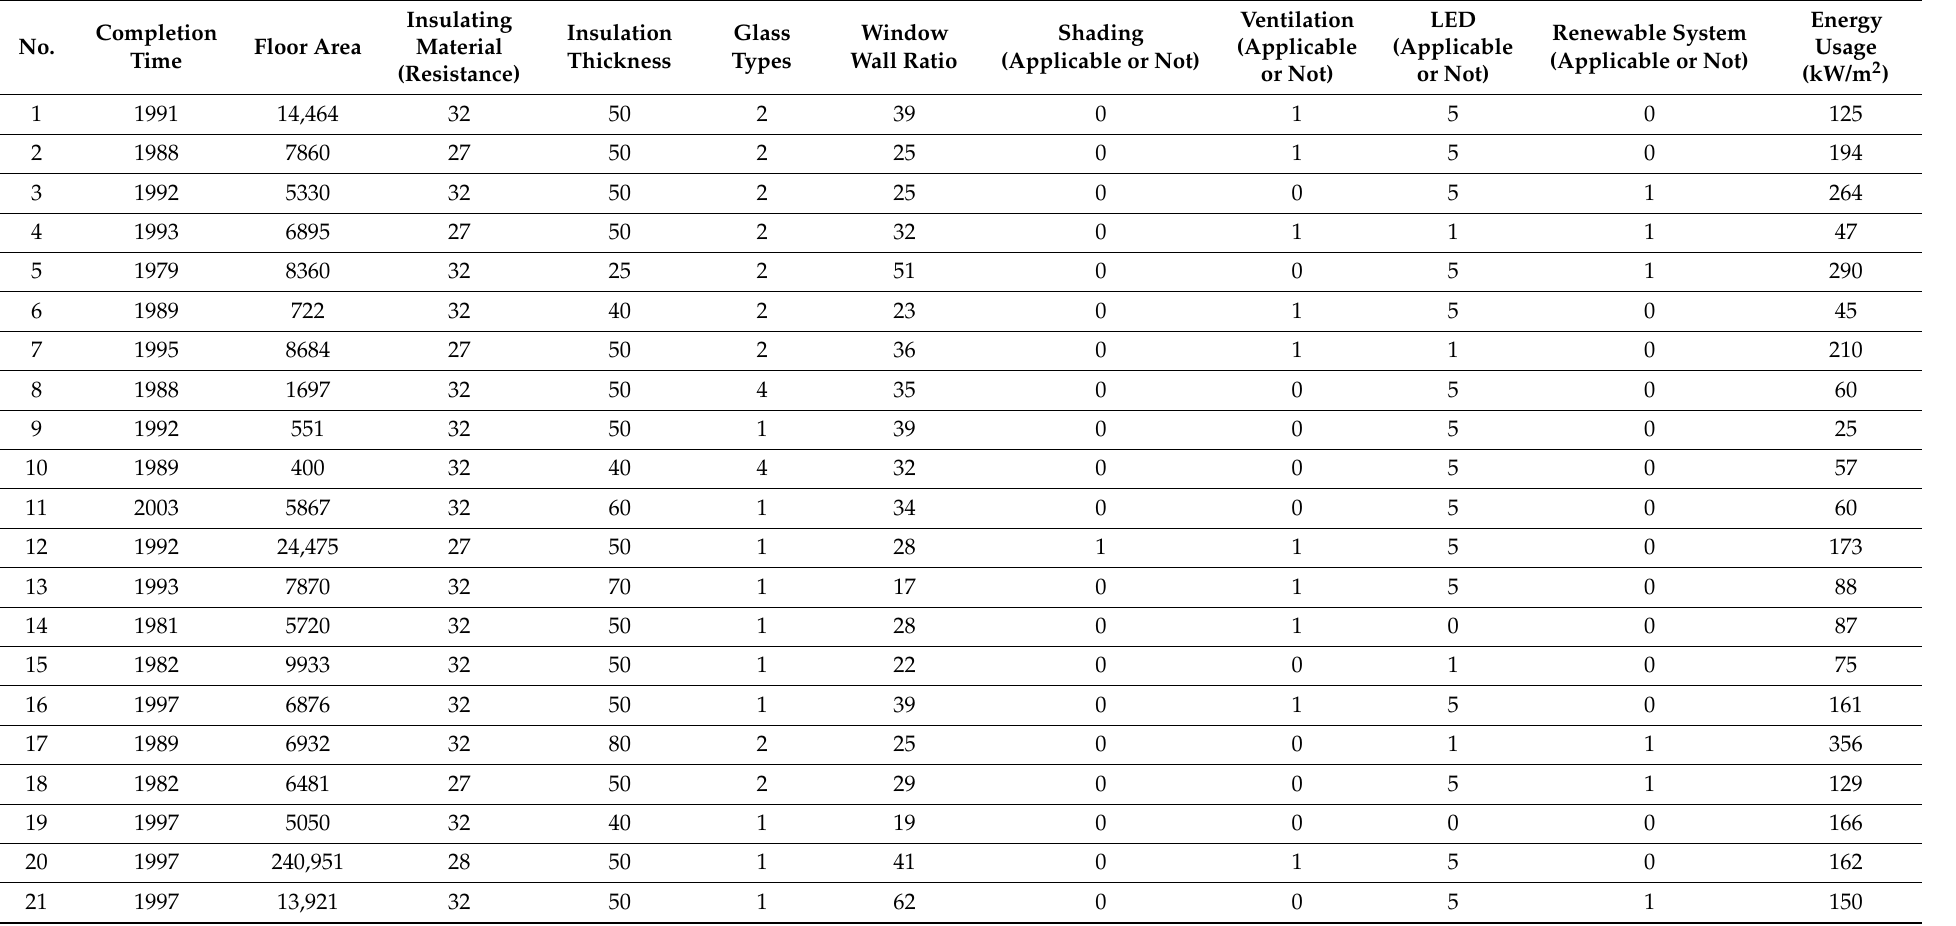
Table A1. Nominal variables converted into ratio scales for correlation